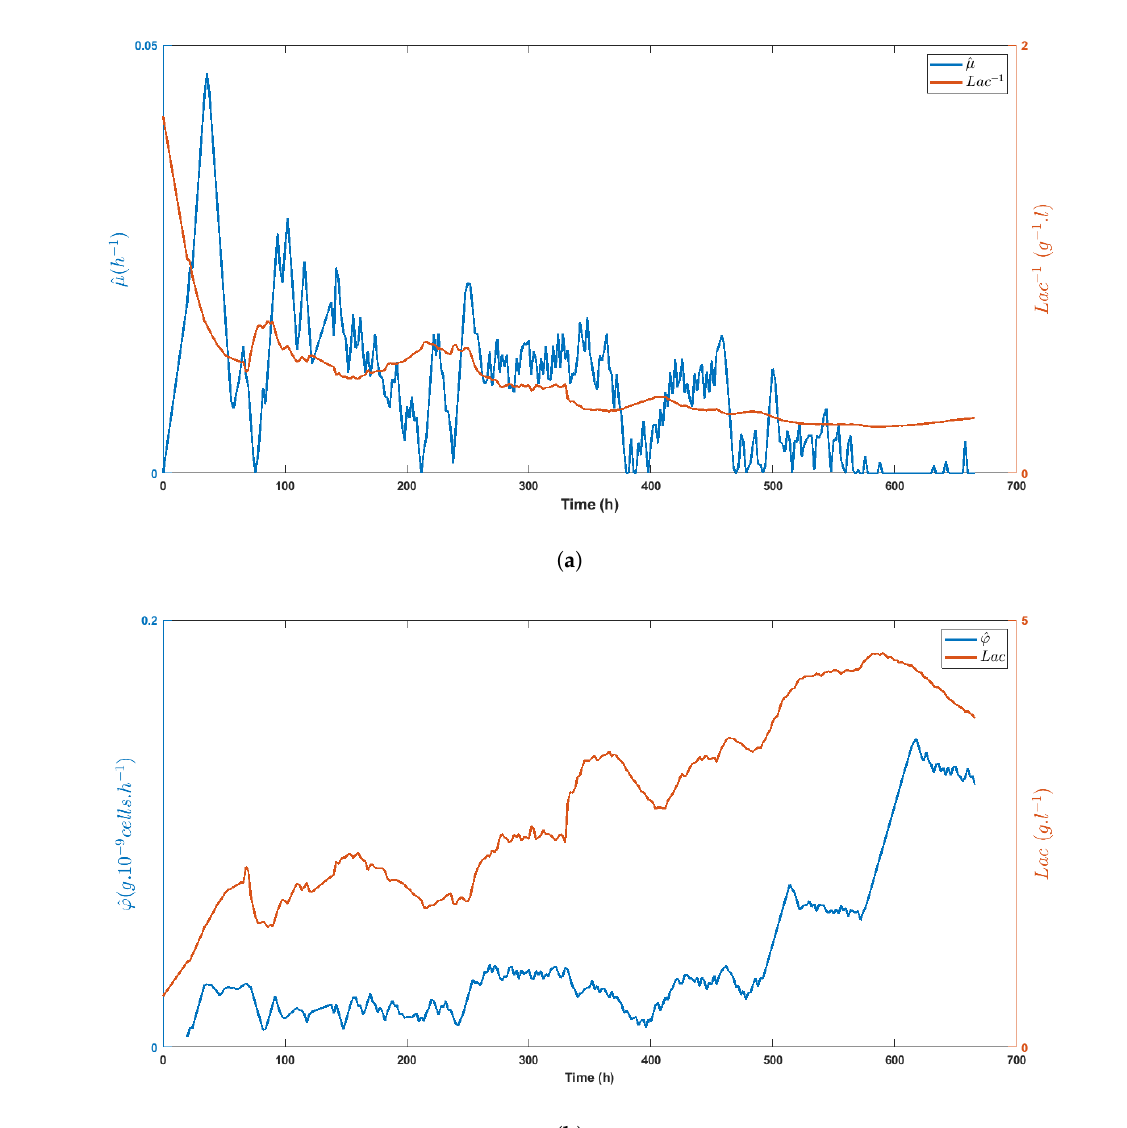
Figure 9. Time evolution of the specific growth rate estimate ˆ µ ( a ) and the specific glucose uptake rate estimate ˆ ϕ ( b) as compared with the lactate concentration (or its inverse), showing the inhibitory effect of lactate on HEK cell